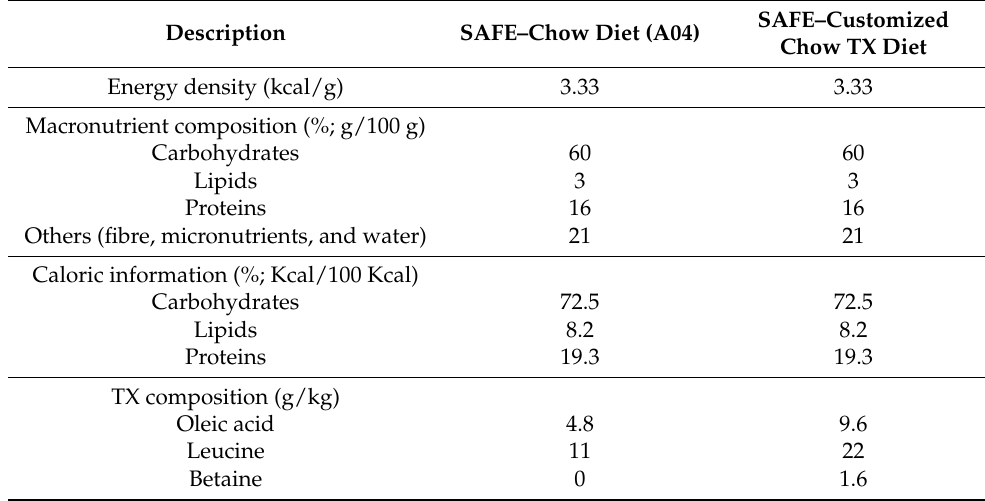
Table 1. Composition of chow diet and its customized version with the TX